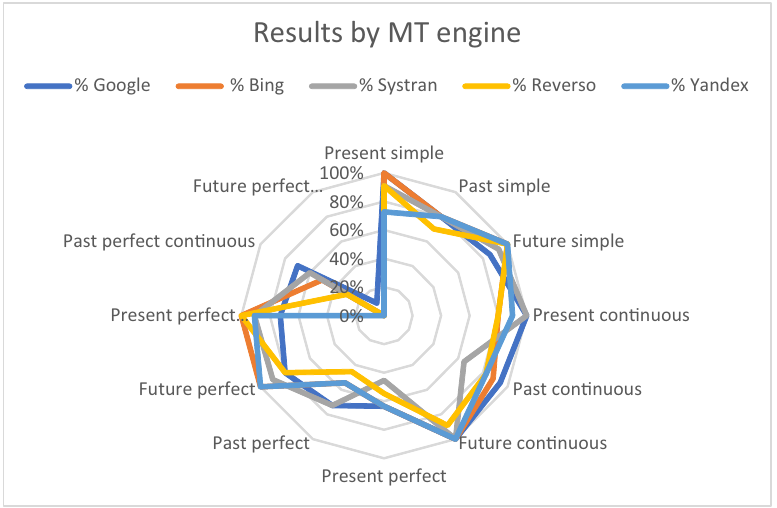
Figure 2: Results by MT engine.